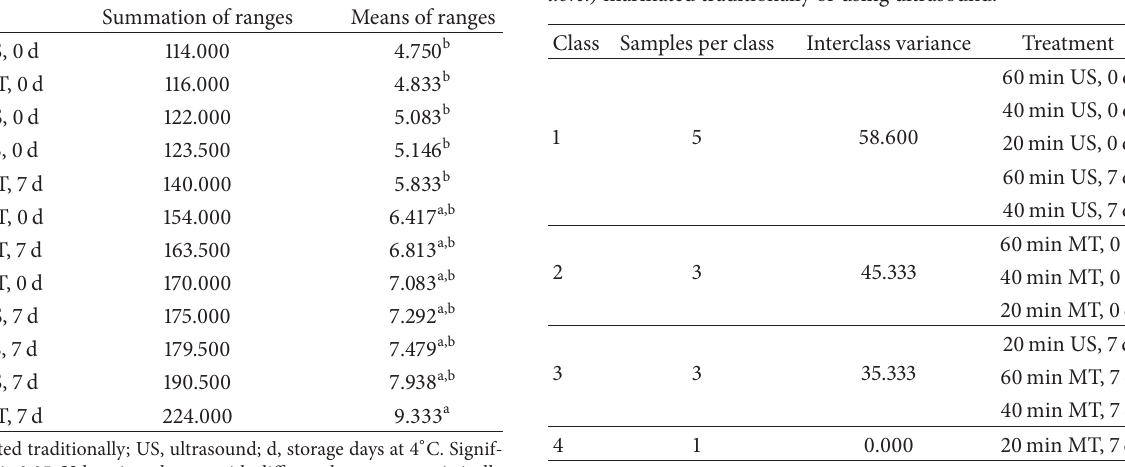
Table 3: Multiple comparisons of beef samples (longissimus dors i ) . Table 4: Results per class and grouping of beef samples (longissimus dorsi) marinated traditionally or using